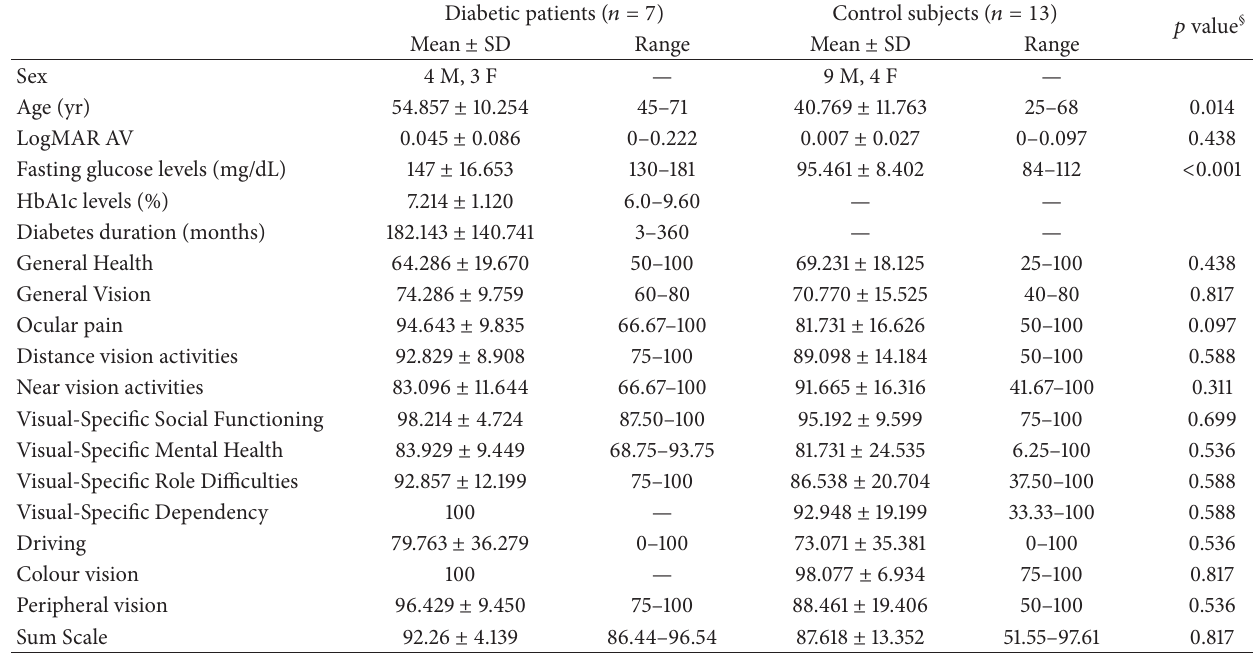
Table 1: Descriptive statistics and scoring Visual-Functioning Questionnaire-25 (VFQ-25) of the diabetic patients and control